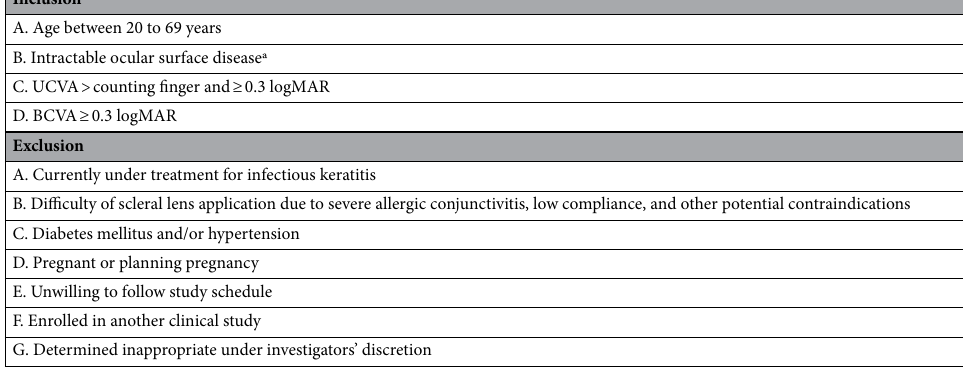
Table 2. Inclusion and exclusion criteria. ªDiagnosed with either of the following intractable ocular surface disease; severe dry eye (dry eye symptoms with Schirmer test ≤ 5 mm), persistent epithelial defect, chemical burn, Stevens–Johnson syndrome, ocular pemphigoid or chronic graft-versus-host disease. Also, clinically refractive to medical treatment, such as artificial tears, topical steroids and autologous serum eyedrops, for more than 6 months. UCVA: uncorrected visual acuity, logMAR: log of minimal angle of resolution, BCVA: best-corrected visual acuity.